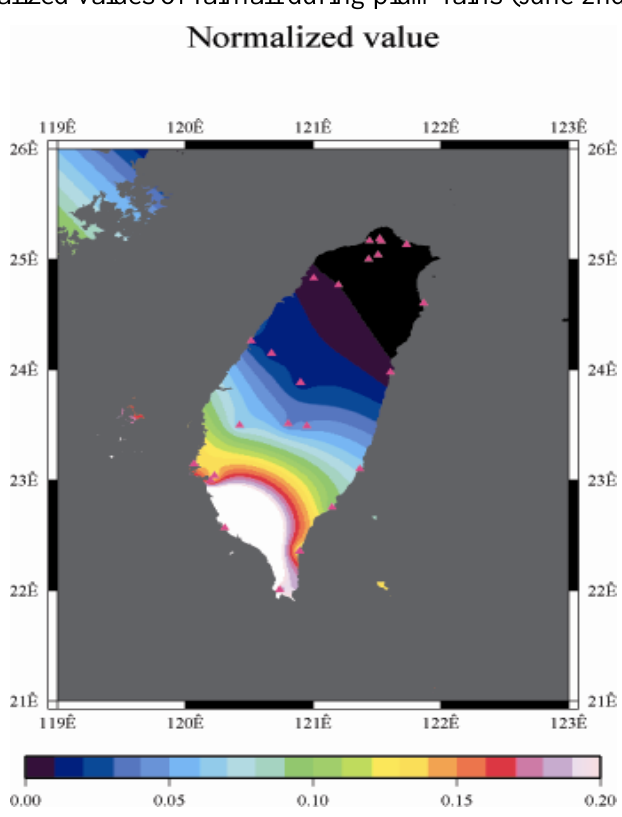
Figure 23. Normalized values of rainfall during plum rains (June 2nd, 2008, 5:00